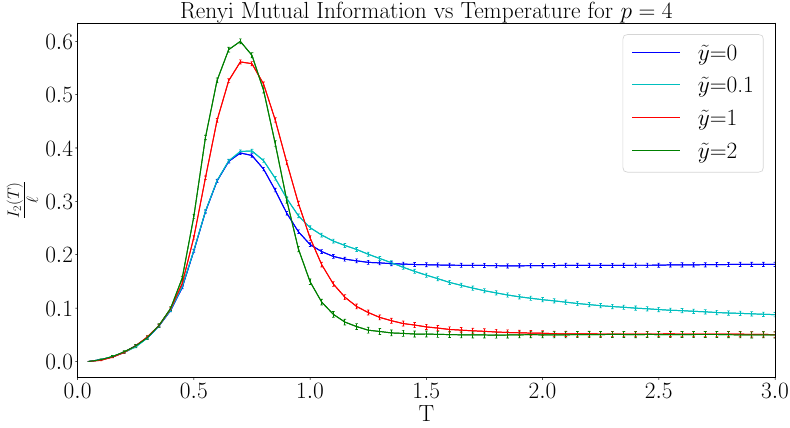
Figure 7 . Mutual information of (4.26) for p = 4 and various values of ~ y . We use lattice size N =